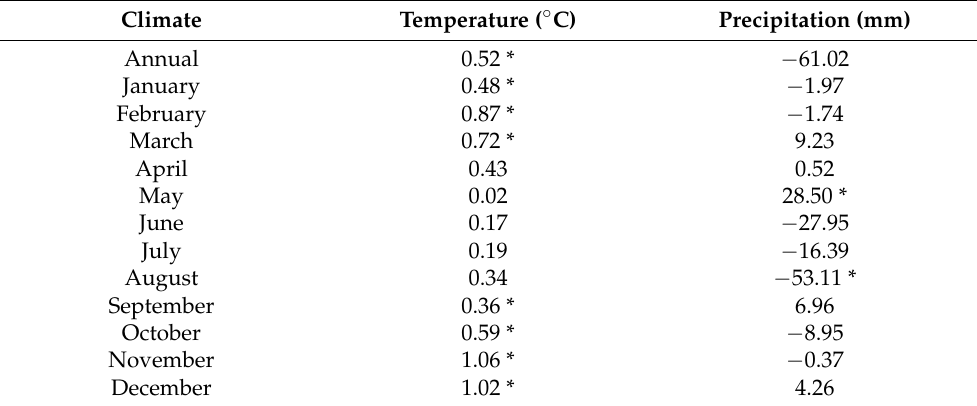
Table A1. Difference in mean temperature and total precipitation in monthly and annual resolution, before and after 1980 (based on Climatic Research Unit climate data).